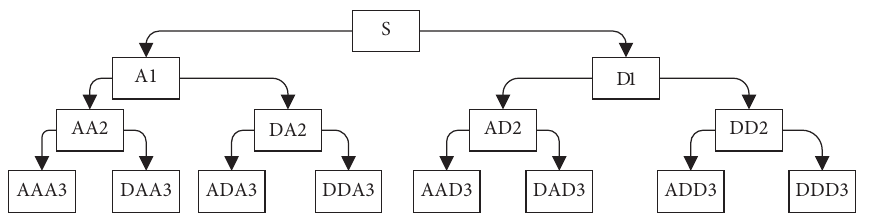
Figure 2: The wavelet packet 3-layer